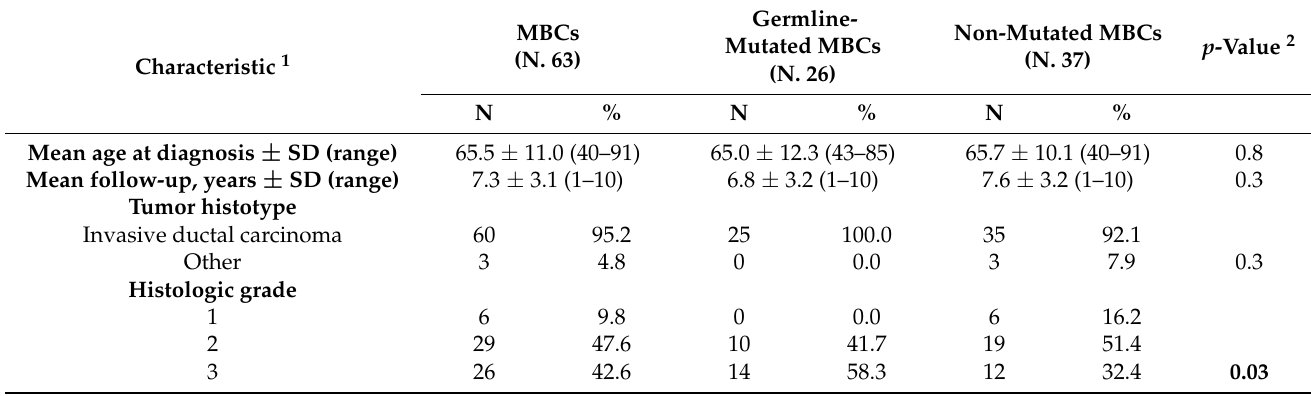
Table 1. Clinical–pathologic characteristics of the 63 MBCs analyzed in this study and comparison between germline- mutated and non-mutated